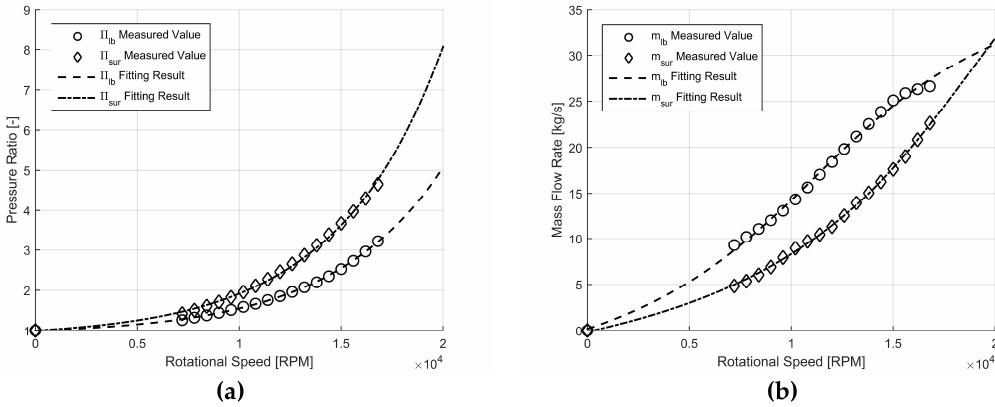
Figure 4. Measured pressure ratio and mass flow rate at the boundary of surging zone and low pressure ratio zone and corresponding fitting result: ( a ) pressure ratio; ( b ) mass flow rate.